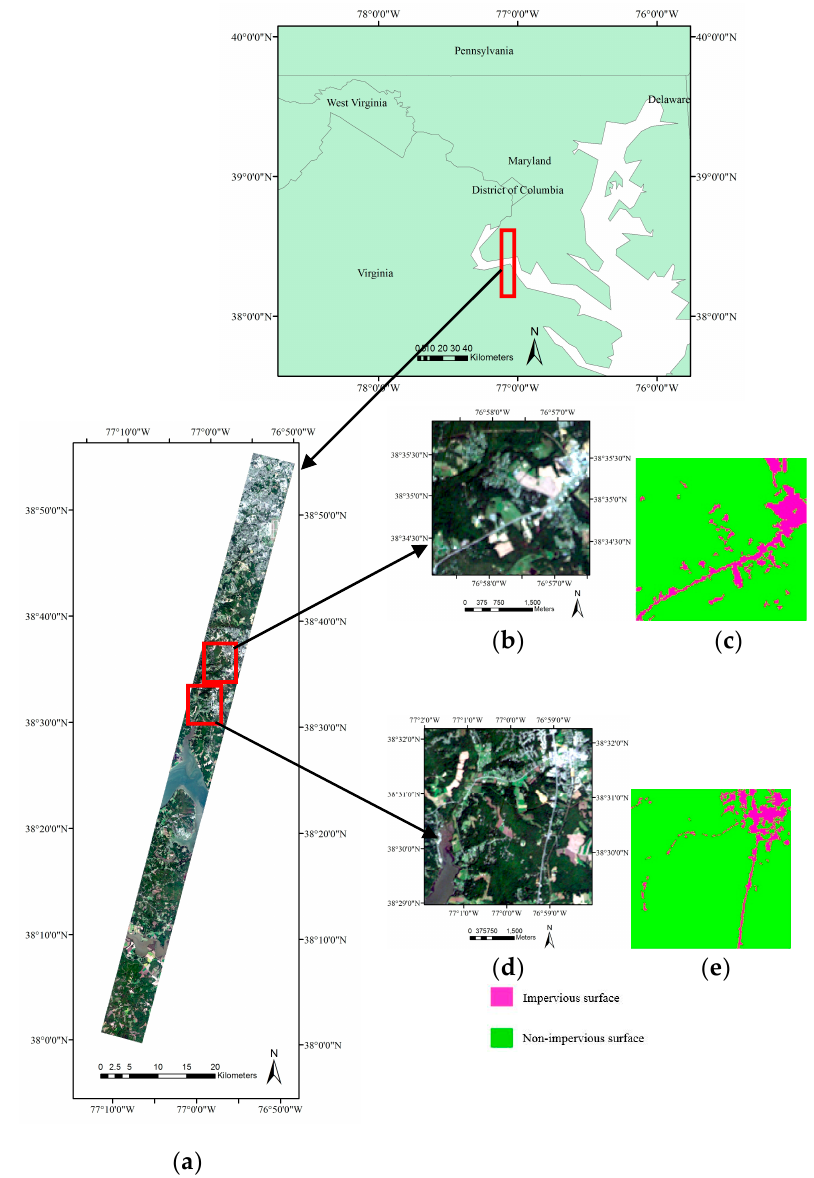
Figure 1. The geographic location of the Hyperion data: ( a ) true color composite image; ( b ) dataset 1; ( c ) dataset 1 ground truth; ( d ) dataset 2; and ( e ) dataset 2 ground truth. The second ROSIS-03 sensor dataset is the center of Pavia. The original image size was 1096 × 1096 pixels. A poor quality area in the image was removed. The remaining “two-part”